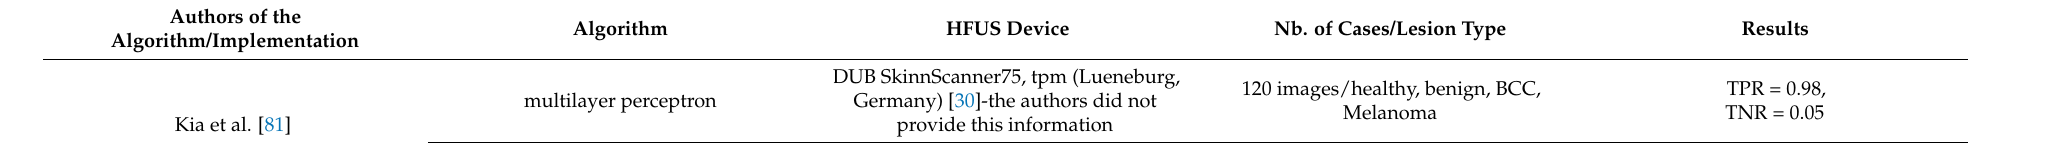
Table 8. Skin lesion classification summary (part